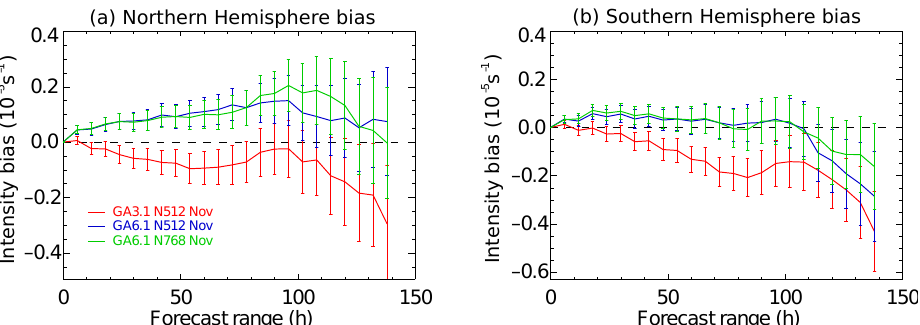
Figure 10. Bias in extra-tropical cyclone intensity (measured by 850hPa relative vorticity) as a function of forecast lead time from data assimilation trials run through November–December 2012. This is obtained from cyclone tracking using Reading University’s TRACK algorithm (Hodges, 1995). Red is the previously operational GA3.1. Blue and green show GA6.1 trials at N512 and N768 respectively.